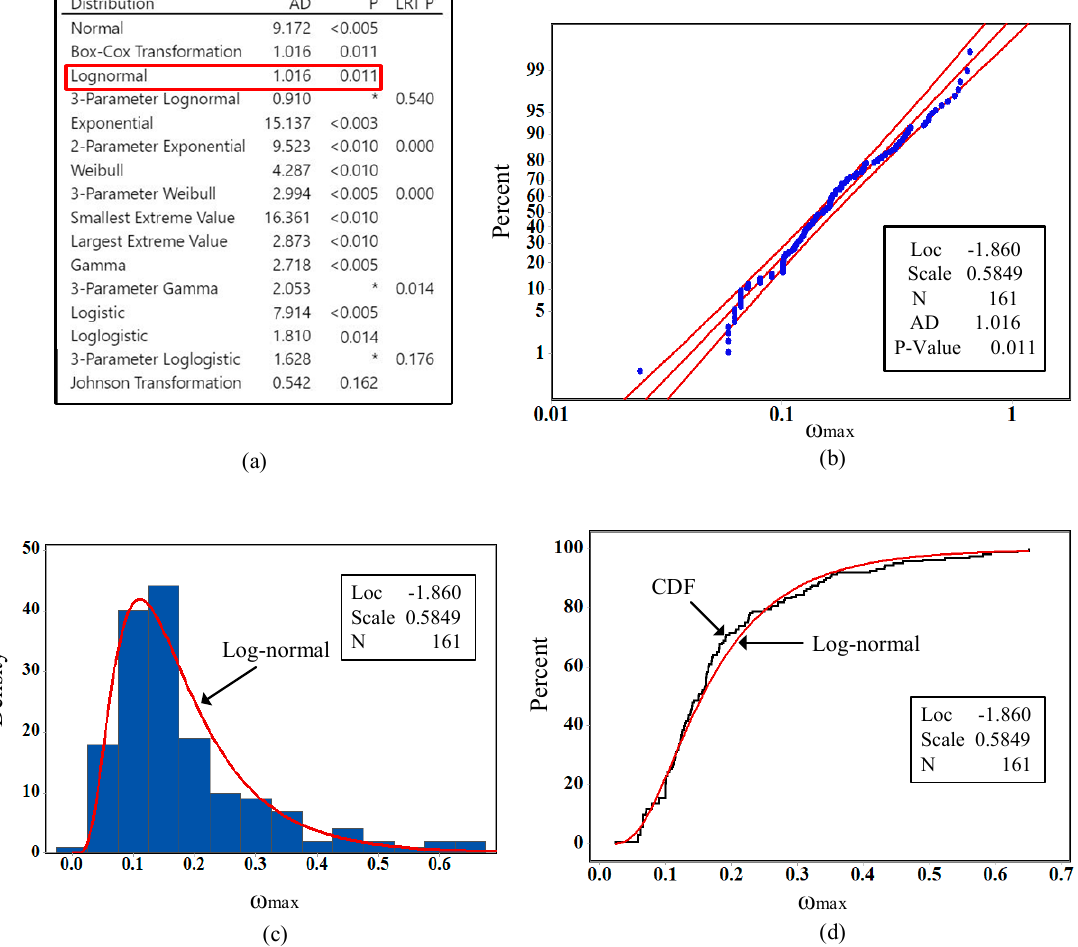
Figure 6. Identifying probability distribution for ω max . ( a ) Goodness of fit test results for 16 different distribution tests; ( b ) probability plot of ω max ; ( c ) histogram of ω max ; ( d ) comparison of cumulative probability (CDF) curve against the log-normal distribution. AD, Anderson–Darling.